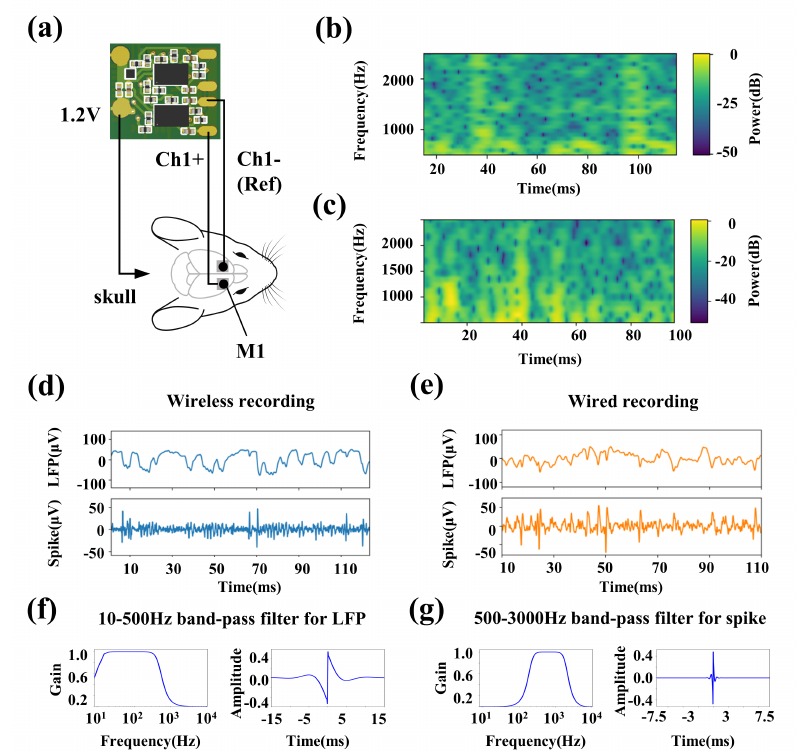
Figure 4. The waveforms comparison of wireless recording microsystem and apollo II wired recording system in vivo. ( a ) Schematic of the recording sites and the electrode connections. ( b ) The multi − taper spectrograms of recorded spikes by the wireless recording microsystem. ( c ) The multi − taper spectro- grams of recorded spikes by the Apollo II wired recording system. ( d ) The recorded spontaneous LFPs and spikes by the wireless recording microsystem. ( e ) The LFPs and spikes by the Apollo II wired recording system. ( f ) The specification of 10–500 Hz second − order Butterworth band-pass filter and its step response. ( g ) The specification of 500–3000 Hz third − order Butterworth band-pass filter and its step